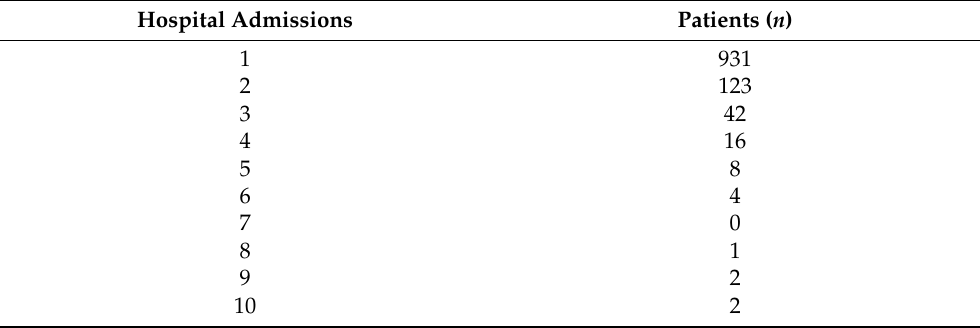
Table 2. Number of hospital admissions of geriatric patients with mTBI due to a fall.